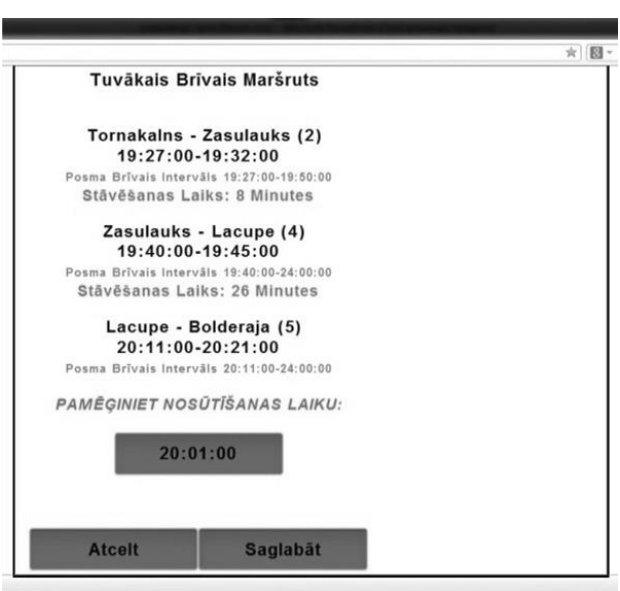
Fig. 8. Result before the optimization.